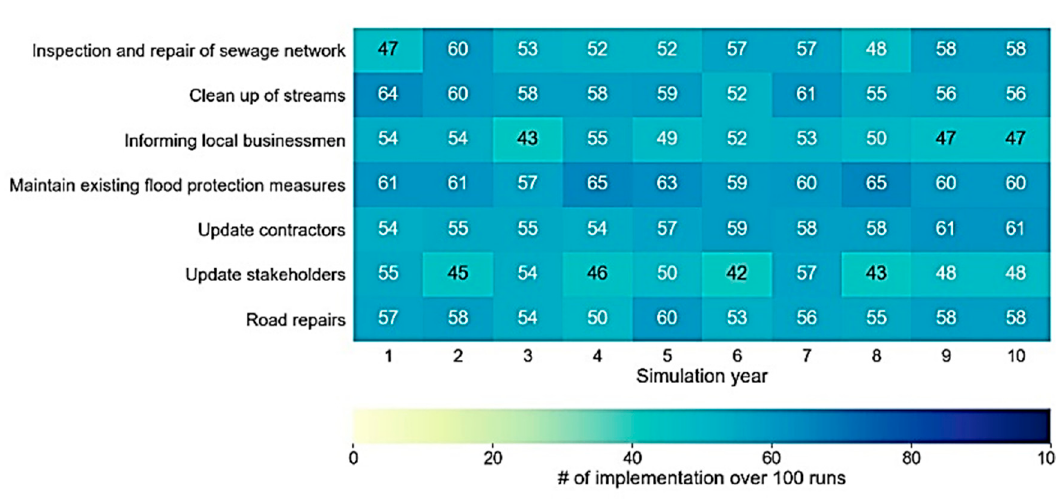
Figure 12. Comparison of average times of implementation of flood preparedness actions for different socio-economic scenarios.